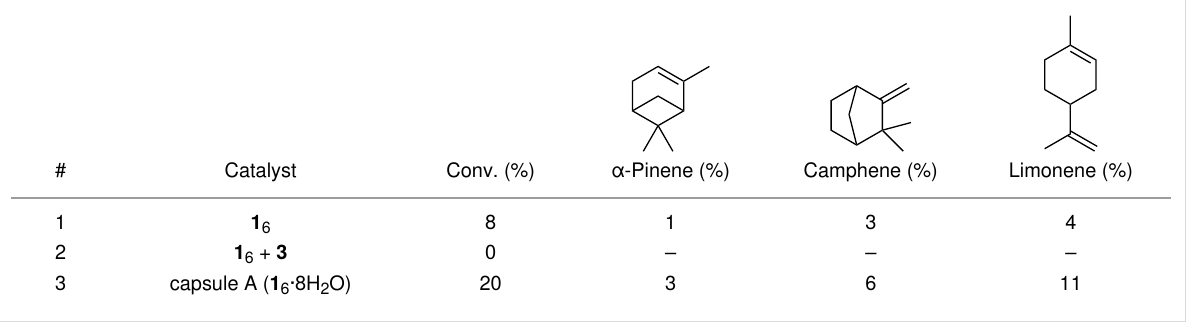
Table 5: Product distribution for the isomerization reaction of β -pinene at rt for 64